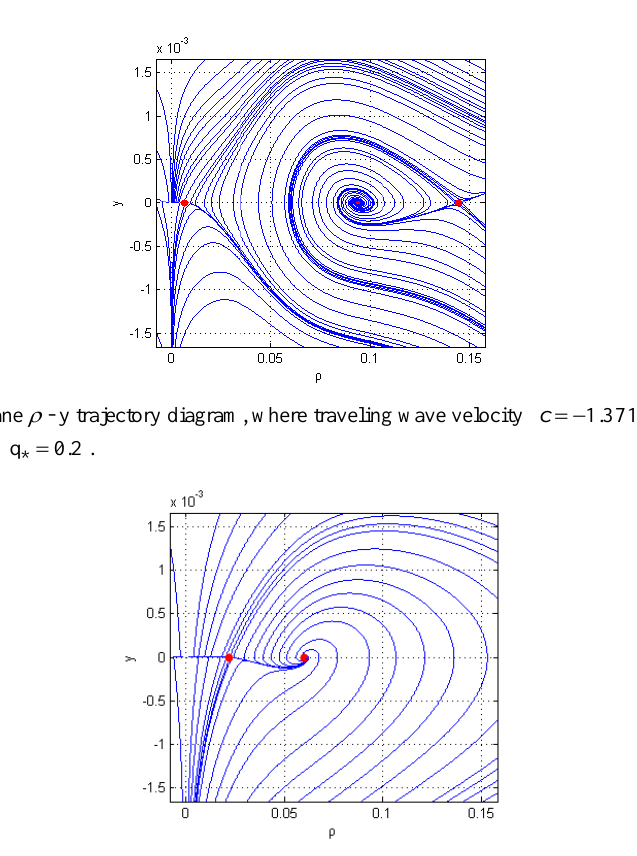
Fig. 2. Phase plane y-  trajectory diagram,where traveling wave velocity 38.1  c , traveling wave parameter 64.0q * 